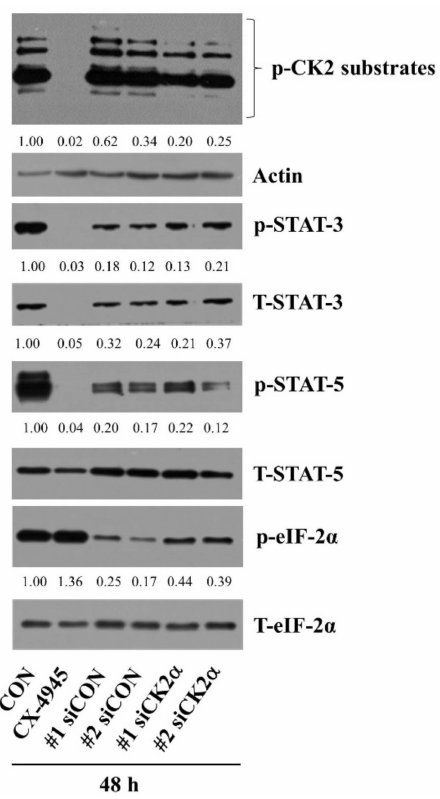
Figure 7. Effects of CX-4945 and CK-2 α siRNA on the expression and phosphorylation of STAT-3, STAT-5, and eIF-2 α in HuCCT-1 cells. HuCCT-1 cells were treated with CX-4945 (20 µ M) or vehicle control (DMSO) or transfected with 200 pM of control siRNA (siCon) or CK-2 siRNA (siCK2 α ) for 48 h. Whole-cell lysates were prepared and analyzed for levels of p-CK-2 substrates, p-STAT-3, T-STAT-3, p-STAT-5, T-STAT-5, p-eIF-2 α , T-eIF-2 α , or β -actin by Western